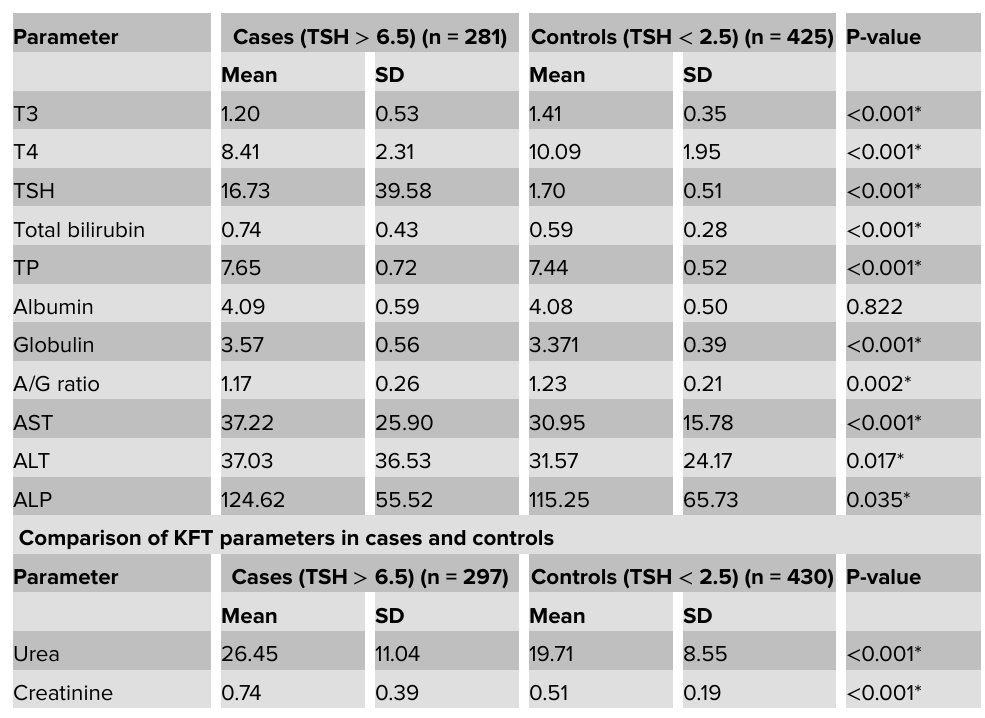
Table 2: Comparison of LFT parameters in cases and controls.